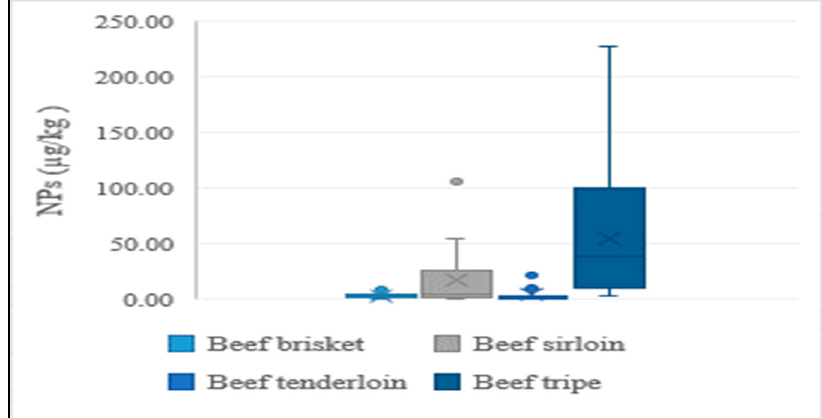
Figure 4. Average concentration of NPs in different edible parts of beef.